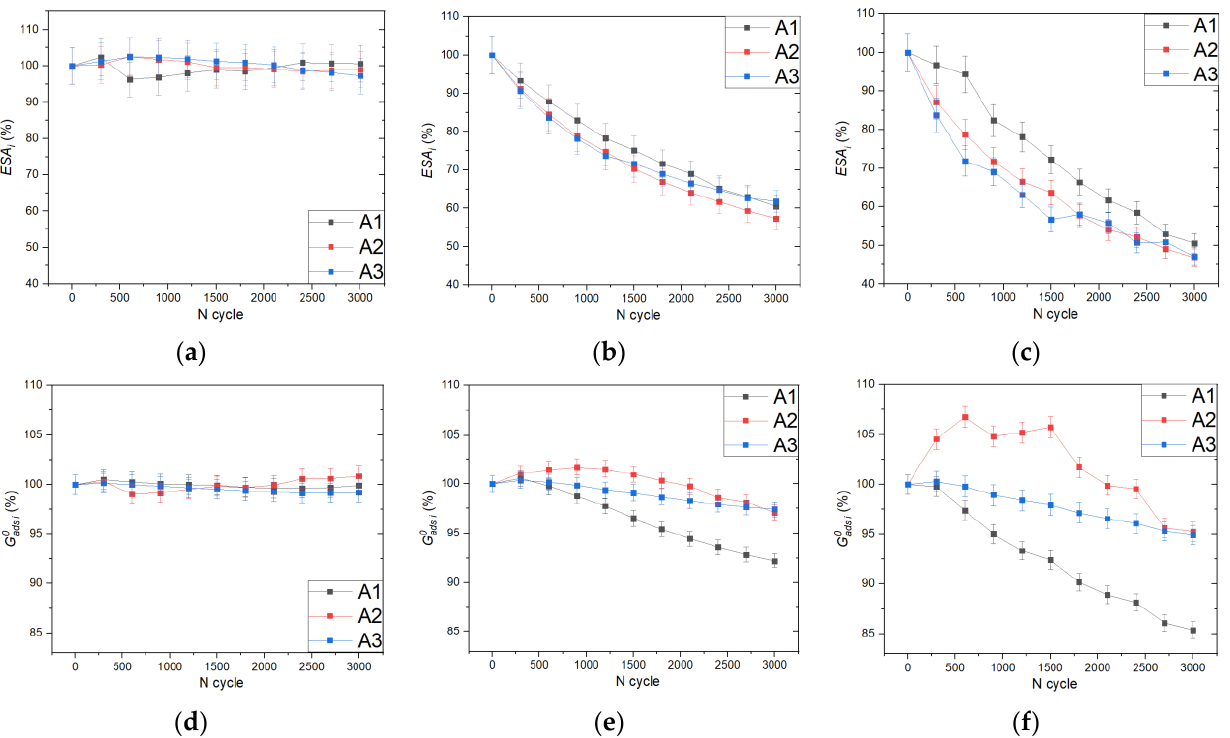
Figure 6. Variation of the ESA and adsorption energy for peaks A1, A2, and A3 normalized to initial values with an increasing number of the AST cycles for the Pt black ( a , d ), Pt 40 /C ( b , e ), and Pt 20 /C ( c , f ) samples. The trends obtained characterize the stability of the electrocatalyst and changes in the structure of platinum nanoparticles during the AST cycles.